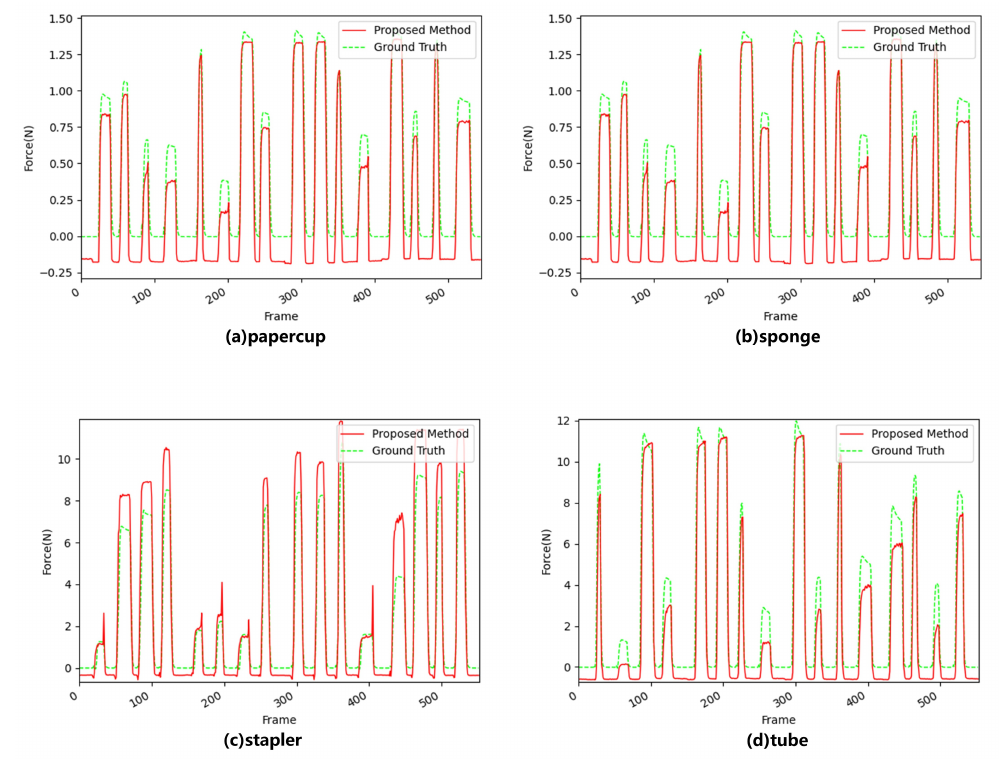
Figure 11. Predicted value and ground truth value results of the estimation of the interaction force using the LRCNN with